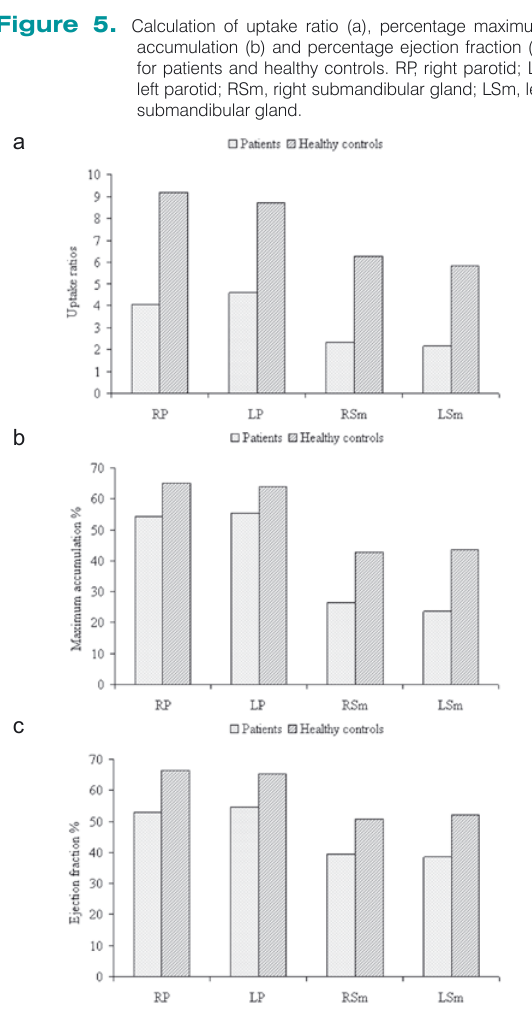
Figure 5. Calculation of uptake ratio (a), percentage maximum accumulation (b) and percentage ejection fraction (c) for patients and healthy controls. RP, right parotid; LP, left parotid; RSm, right submandibular gland; LSm, left submandibular